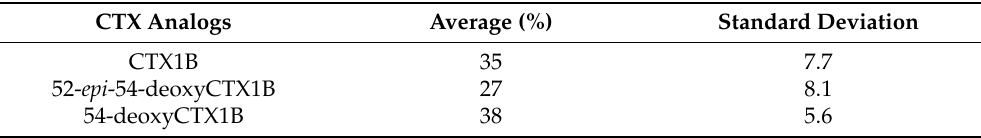
Table 2. The ratios of three analogs, CTX1B, 52- epi -54-deoxyC TX1B, and 54-deoxyCTX1B in the flesh of V. louti specimens from which quantifiable levels of CTXS were detected ( n = 36). CTX Analogs Average (%) Standard Deviation